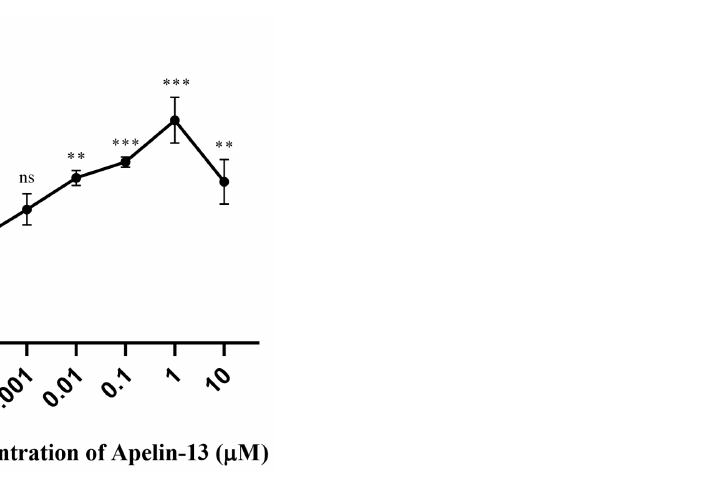
Figure 7. Quantitative analysis of relative cell viability with various concentrations for Apelin-13 by